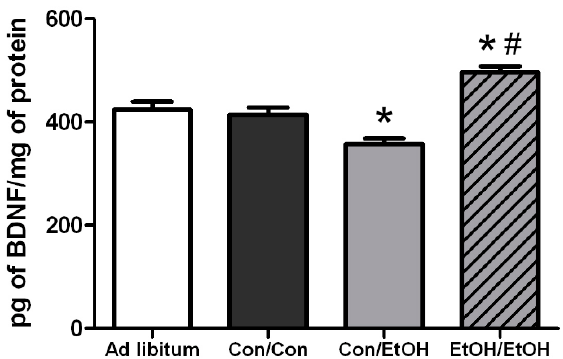
Figure 8. Ethanol Experience-Contingent Effects on BDNF. Concentrations of brain derived neurotrophic factor (BDNF) were determined by ELISA in the hippocampus. BDNF was decreased by approximately 15% in Con/EtOH treated animals compared with Con/Con or ad libitum groups but increased by 20% in the EtOH/EtOH group. * p < 0.05 vs. ad libitum and Con/Con groups; # p < 0.05 vs. to Con/EtOH.